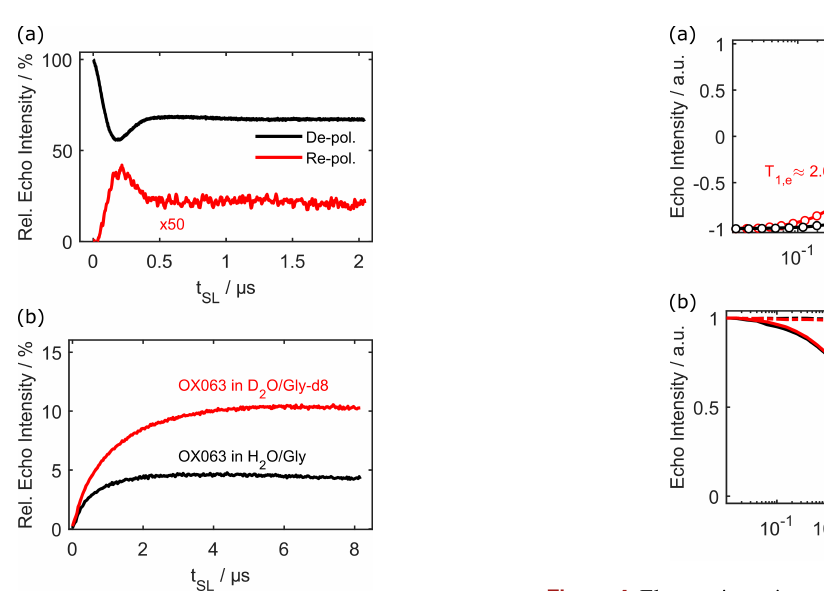
Figure 3. Repolarisation dynamics. Panel (a) displays a compari- son of the depolarisation curve in Fig. 1c with the corresponding repolarisation curve that was measured by sweeping the length of the second DNP step while keeping the first transfer fixed with op- timised parameters for 100µM OX063 at 80K in protonated sol- vent. Panel (b) shows repolarisation curves using ramped-amplitude (RA) NOVEL in different solvents. In both instances, the pro- tons were polarised and depolarised. All data were measured with 100µM OX063 at 80K.